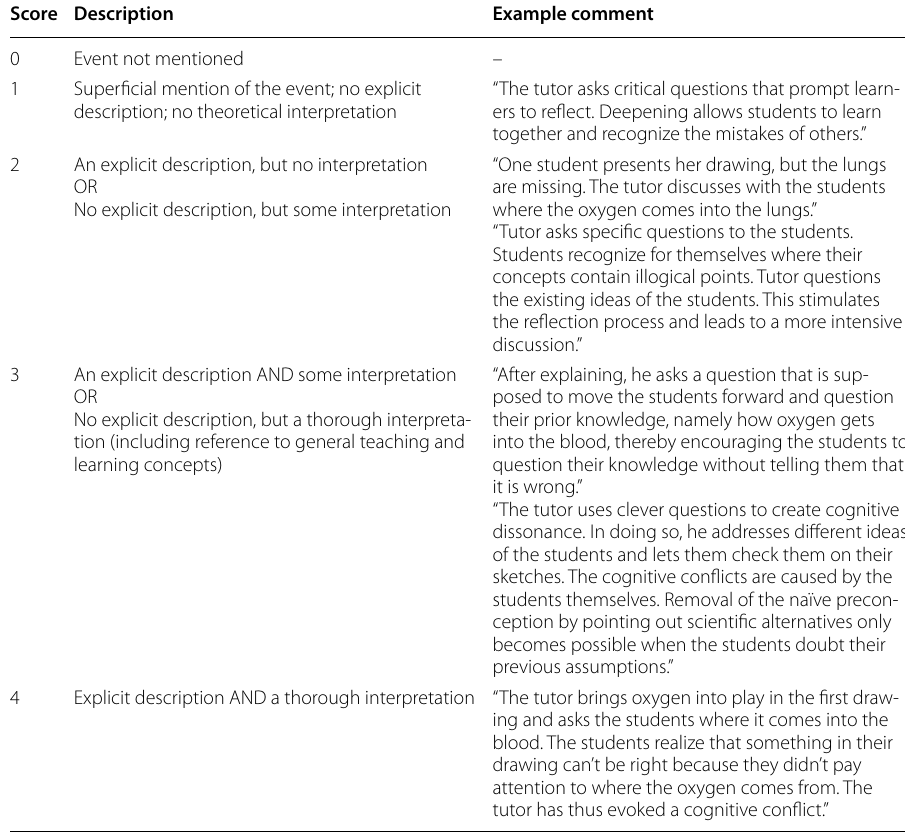
Table 3 Example comments on event “following up on a student’s idea” (Drawing Task Video) Score